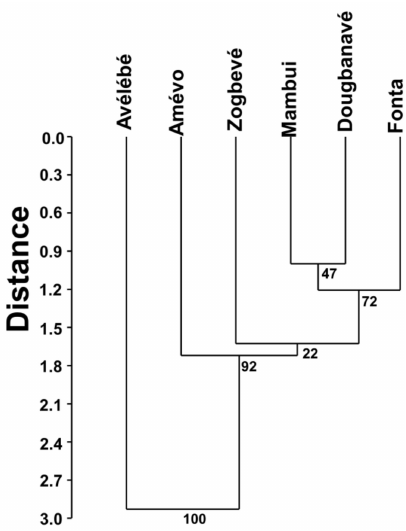
Figure 2. UPGMA dendrogram, with a Euclidean similarity index and 40 bootstraps to com- pute branching measurements, of the dissimilarity among the various forests in terms of the pres- ence/absence of the mammal species recorded at the study area in south-eastern